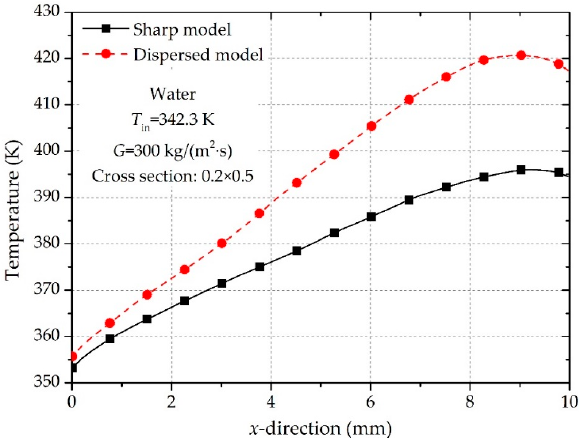
Figure 5. Temperature distribution of the heating wall along the flow stream from simulations using sharp model and dispersed model.